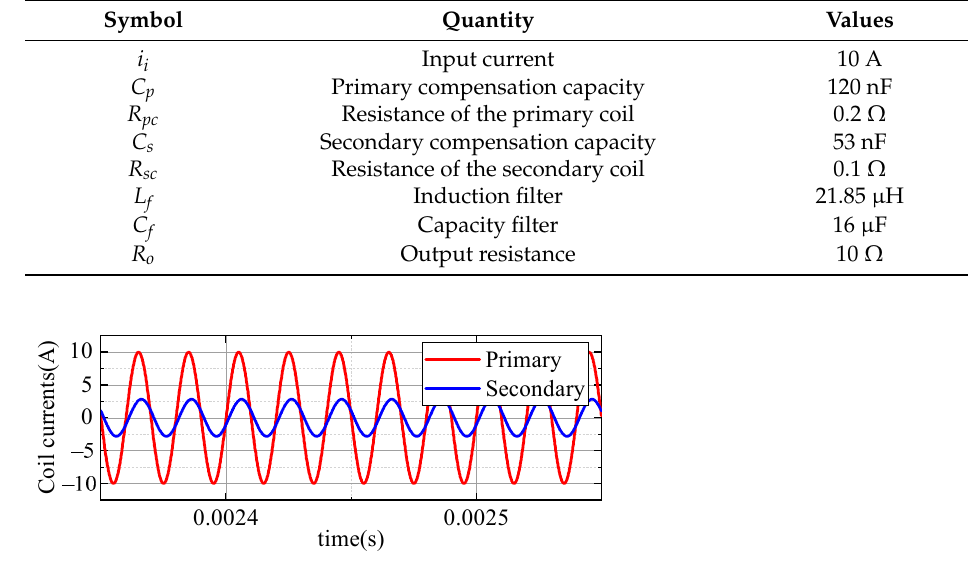
Figure 35. Coupler currents waves with the proposed structure shield.